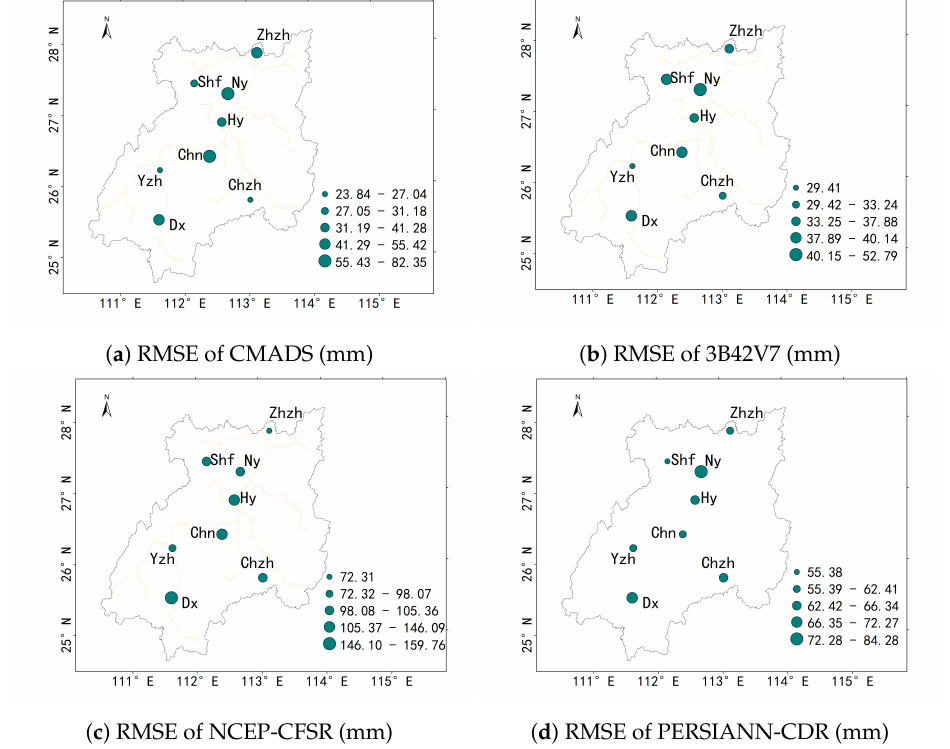
Figure 4. Spatial distribution of the RMSE of monthly precipitation